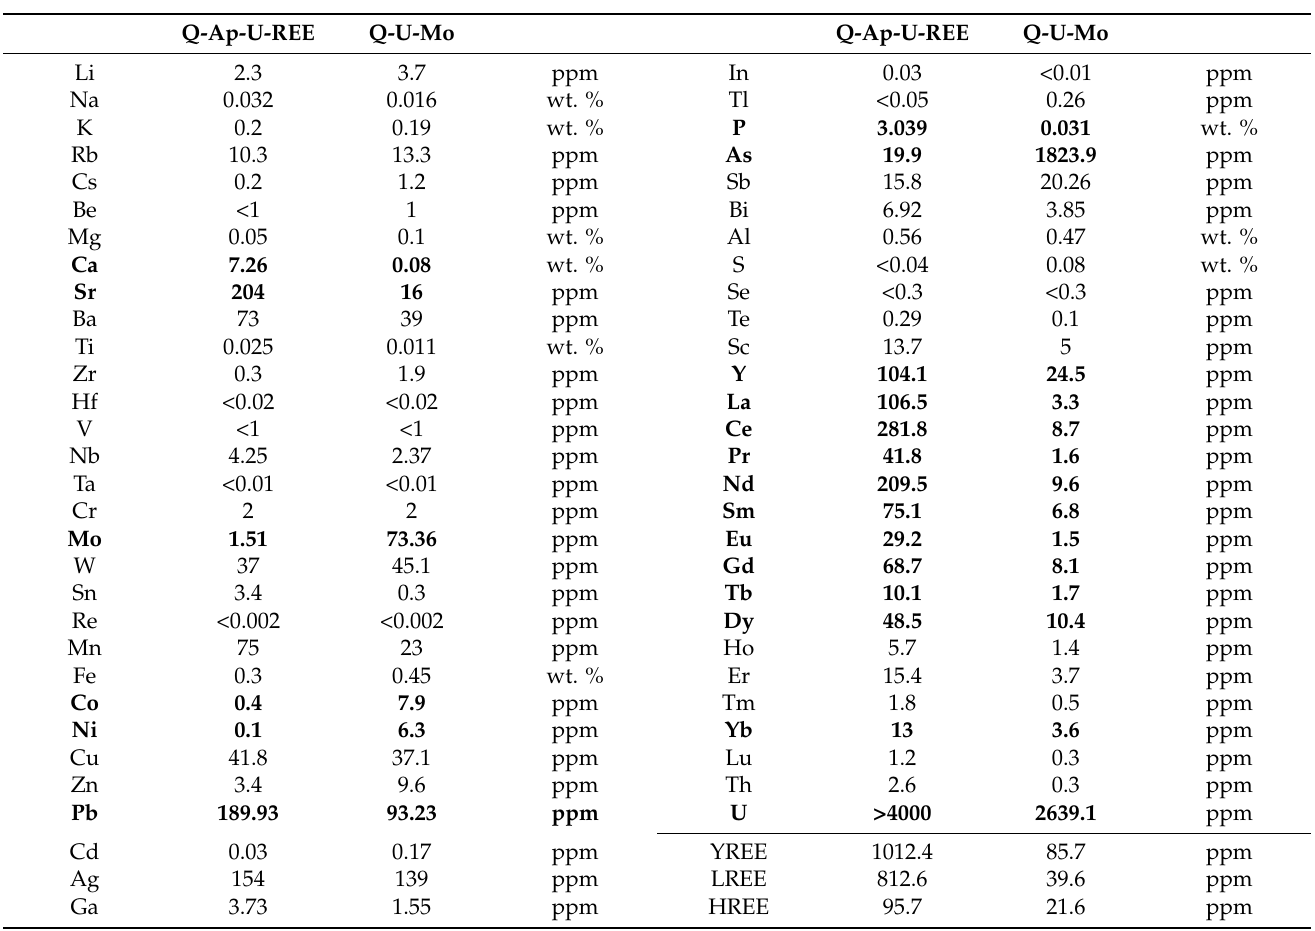
Table 1. Chemical composition of a quartz vein containing U-Mo mineralization (Q-U-Mo) in comparison to the composition of quartz-fluorapatite veins containing U-REE mineralization (Q-Ap-U-REE) from the Majersk á Valley. Elements with significantly different content in both types of veins are highlighted in